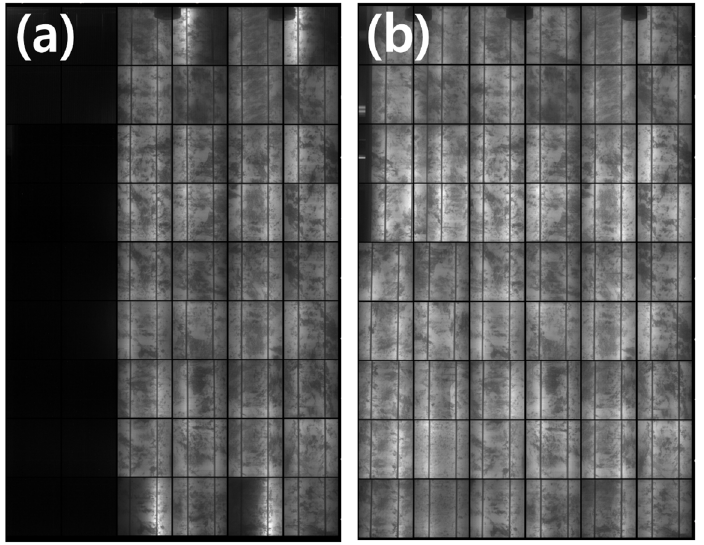
Figure 9. EL images in the module before and after recovery (205A). ( a ) EL image of 205A sample before RSB hotspot repair, ( b ) EL image of 205A sample after RSB hotspot repair